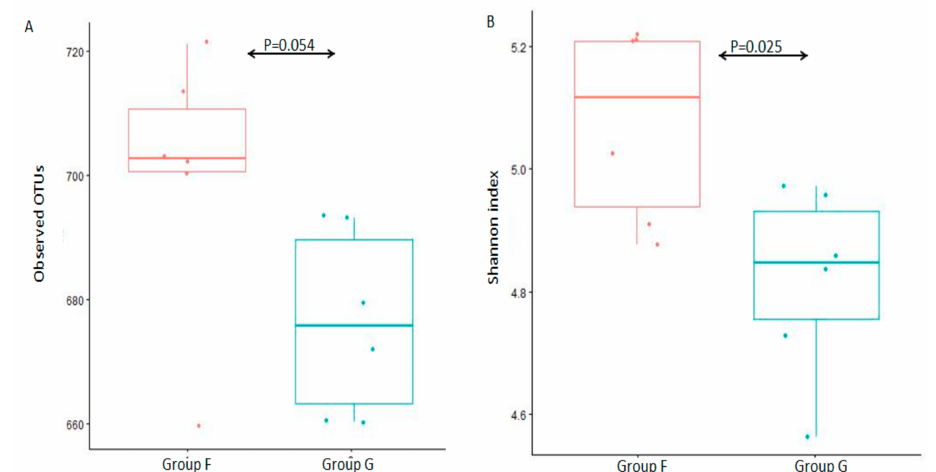
Figure 2. Box-plot representation of alpha diversity. Fecal microbiota were evaluated by the number of observed OTUs ( A ) and Shannon index ( B ) between group F and group G.